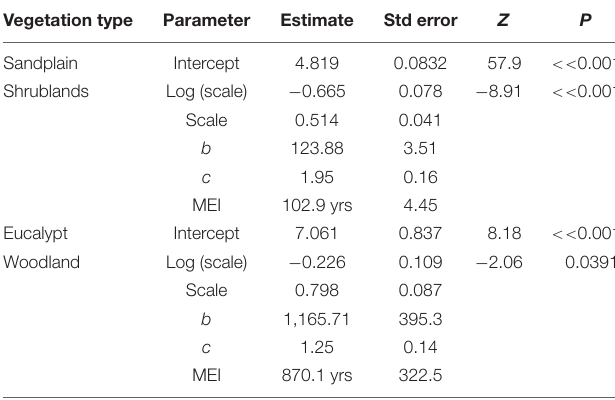
TABLE 5 | Parameters of Weibull model fitted to fire interval data for two major vegetation types of study area. Vegetation